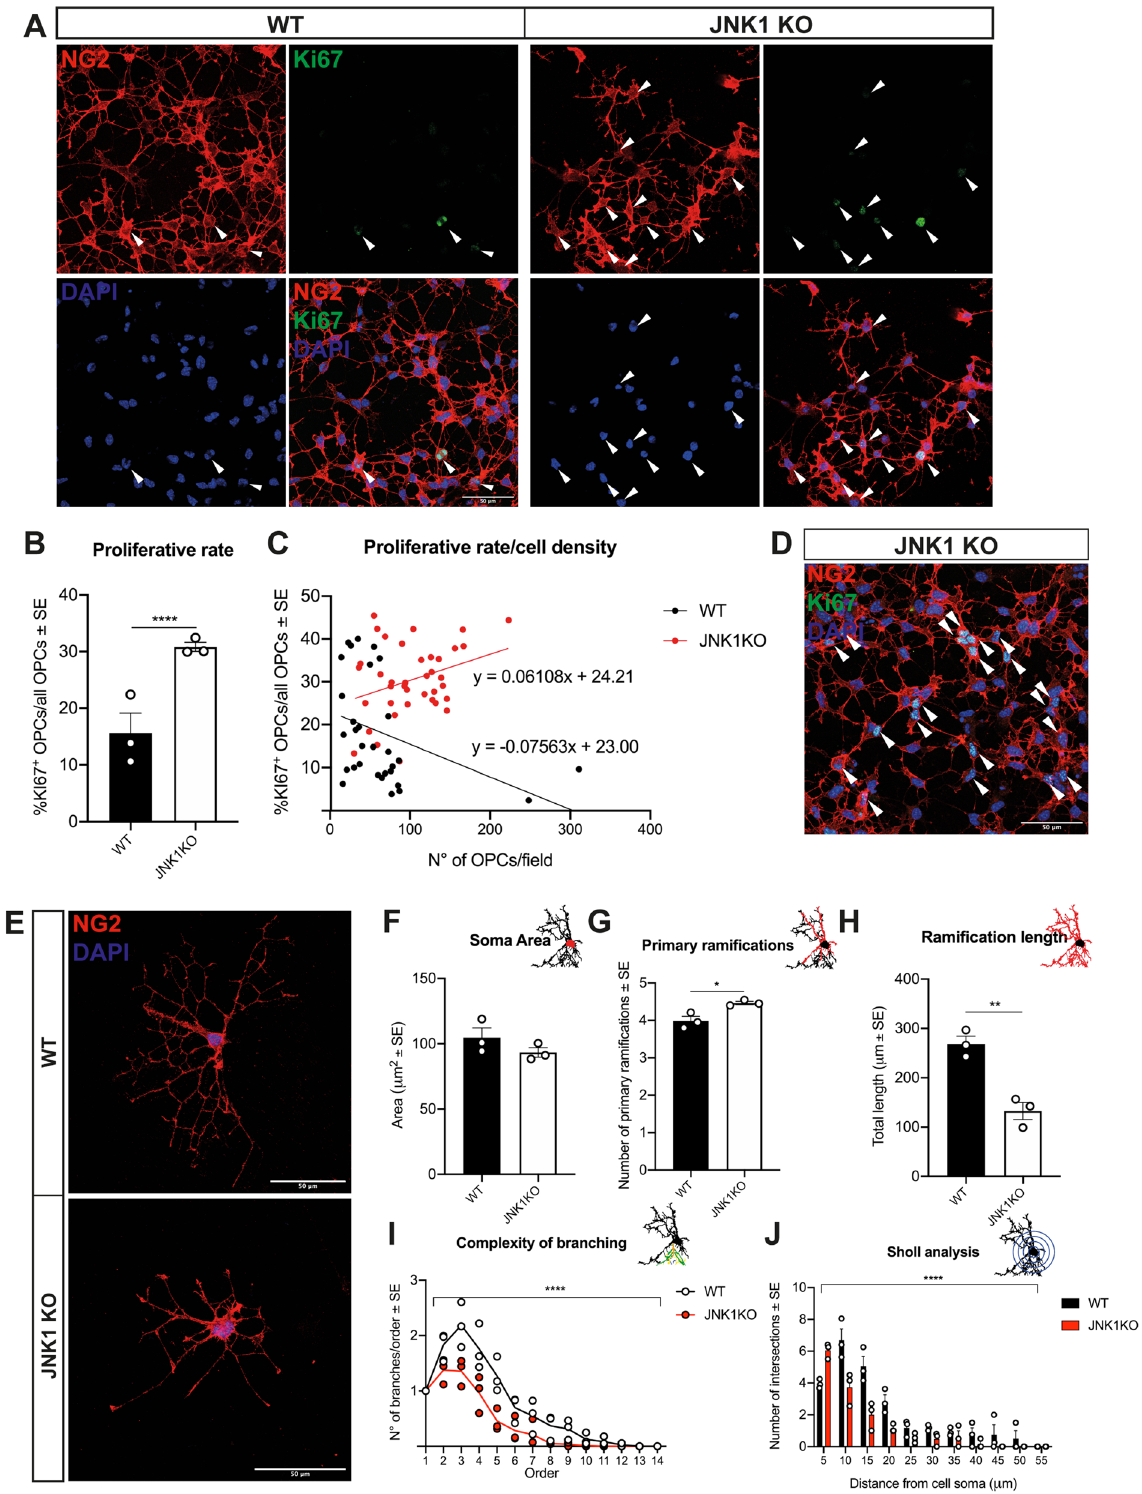
Figure 4. JNK1KO OPCs show higher proliferation and less complex ramifications in vitro . ( A ) Representative images of MACS- sorted cultured WT or JNK1 KO NG2 + (red) OPCs. Ki67 + proliferating cells (green) are indicated by white arrows. DAPI (blue) counterstains cell nuclei. ( B ) Quantification of WT vs JNK1 KO MACS-sorted proliferating OPCs. In ( C ) the proliferative fraction (Ki67 + OPCs over all OPCs) is plotted as a function of the number of OPCs in each analyzed field. The result of this analysis was also confirmed excluding the WT leverage points. ( D ) Representative image of MACS-sorted cultured JNK1 KO OPCs in high cell density. ( E ) Representative images of WT vs JNK1 KO MACS-sorted NG2 + OPCs (red). DAPI (blue) counterstains cell nuclei. ( F–I ) Quantification, through Neurolucida reconstruction, of soma areas ( F ), number of primary ramifications ( G ), total length ( H ) and complexity ( I ) of the ramifications of WT vs JNK1 KO MACS-sorted OPCs. ( J ) Sholl analysis of WT vs JNK1 KO MACS-sorted OPCs. Asterisks in ( I ) and ( J ): Two-way ANOVA (main effect of genotype). Scale bars: 50 μm in ( A ) and in ( D ). WT wild type, NG2 neural/ glial antigen 2, Ki67 Ki67 antigen. *P < 0.05; **P < 0.01; ****P <